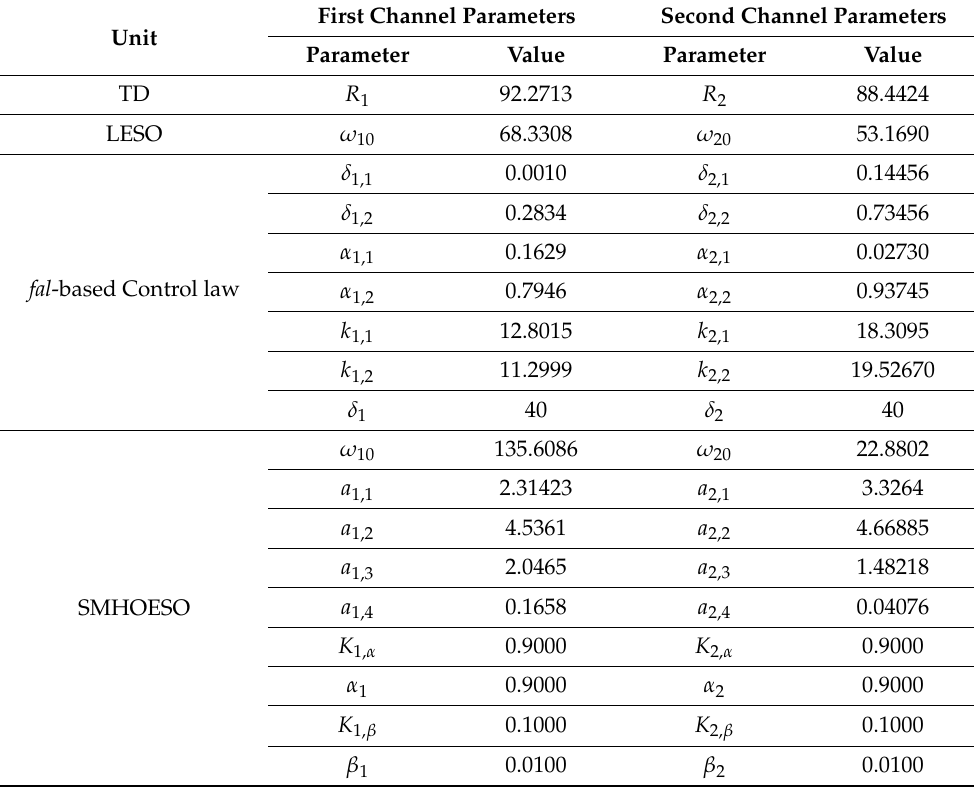
Table 1. The parameters of the ADRC units. First Channel Unit